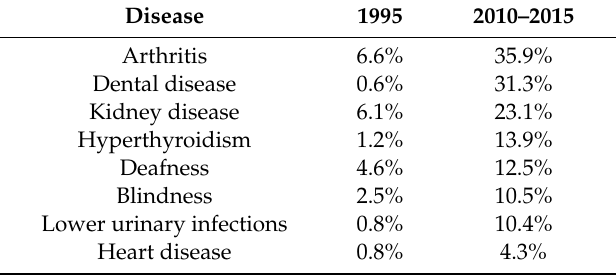
Table 3. Prevalence of disease. Percentages from both surveys of the prevalence of di ff erent diseases as reported by the owners of elderly